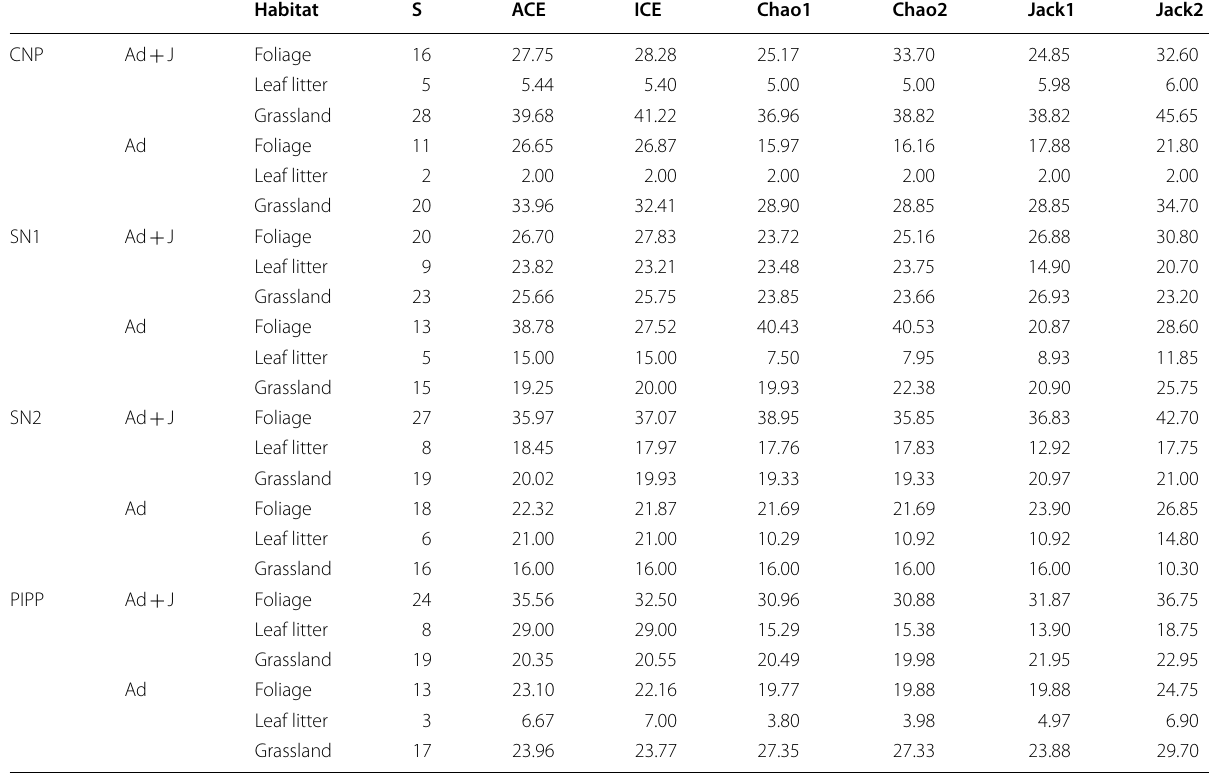
Table 3 Estimation of richness with HTS in the studied area, Eastern Chaco District,